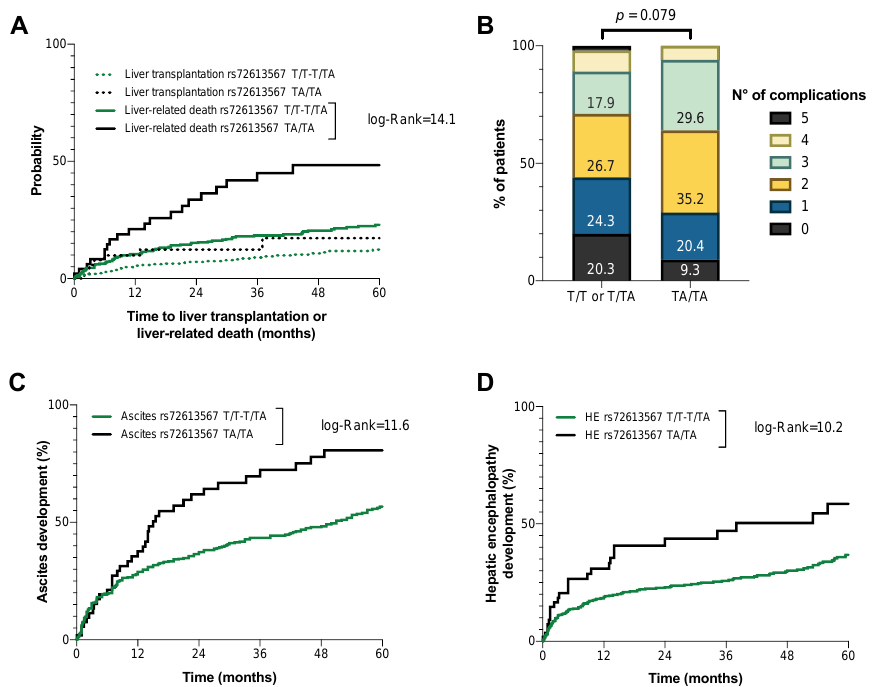
Figure 2. ( A ) Mortality with liver transplantation as a competing event. ( B ) Frequency of patients with an increasing number of cirrhosis complications. Cumulative incidence of ( C ) ascites and ( D ) hepatic encephalopathy development, according to the HSD17B13 rs72613567 genotype. Table 2. Multivariate Cox regression analyses on the impact of the genotype of HSD17B13 rs72613567 on liver transplantation, mortality, and hepatic decompensation.